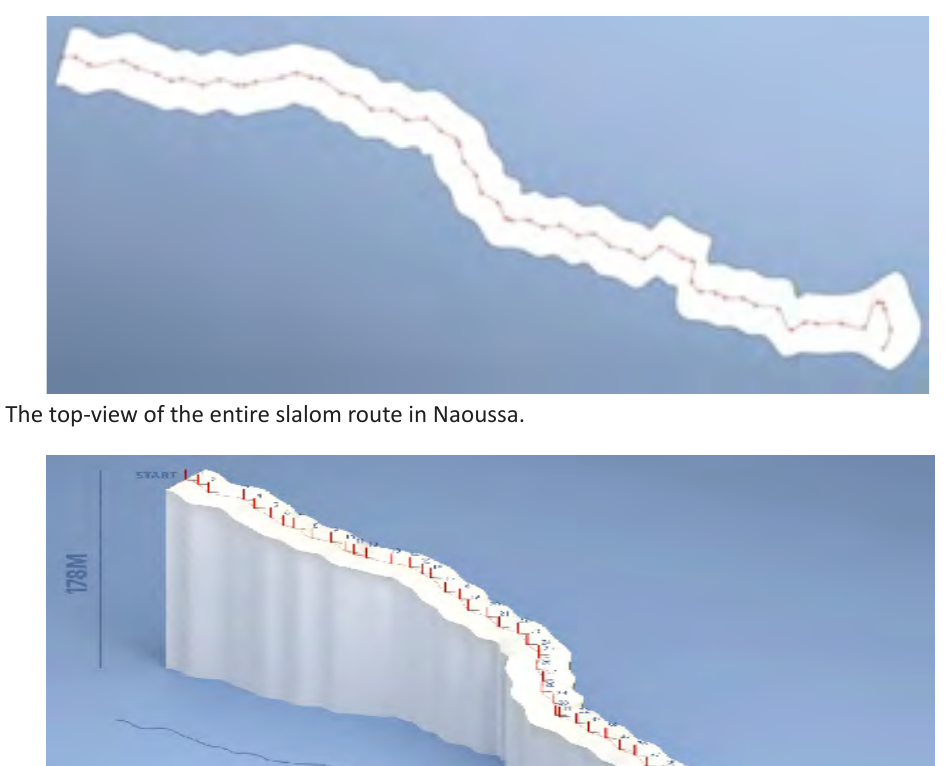
Figure 2. The side-view (Profile) of the entire slalom route in the ski resort “Tria - Pente Pigadia”